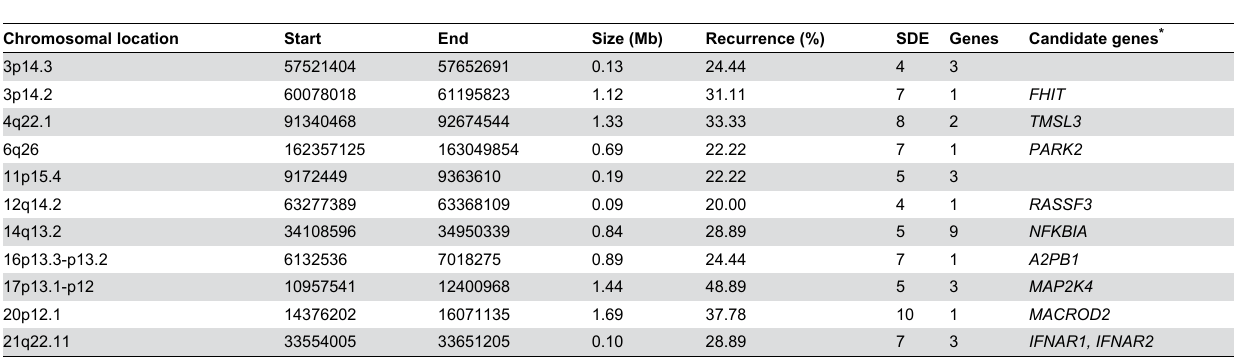
* Candidate genes defined based on cancer-relevant functions. doi: 10.1371/journal.pone.0083859.t001 Table 2. Candidate driver genes in gained FMCR.